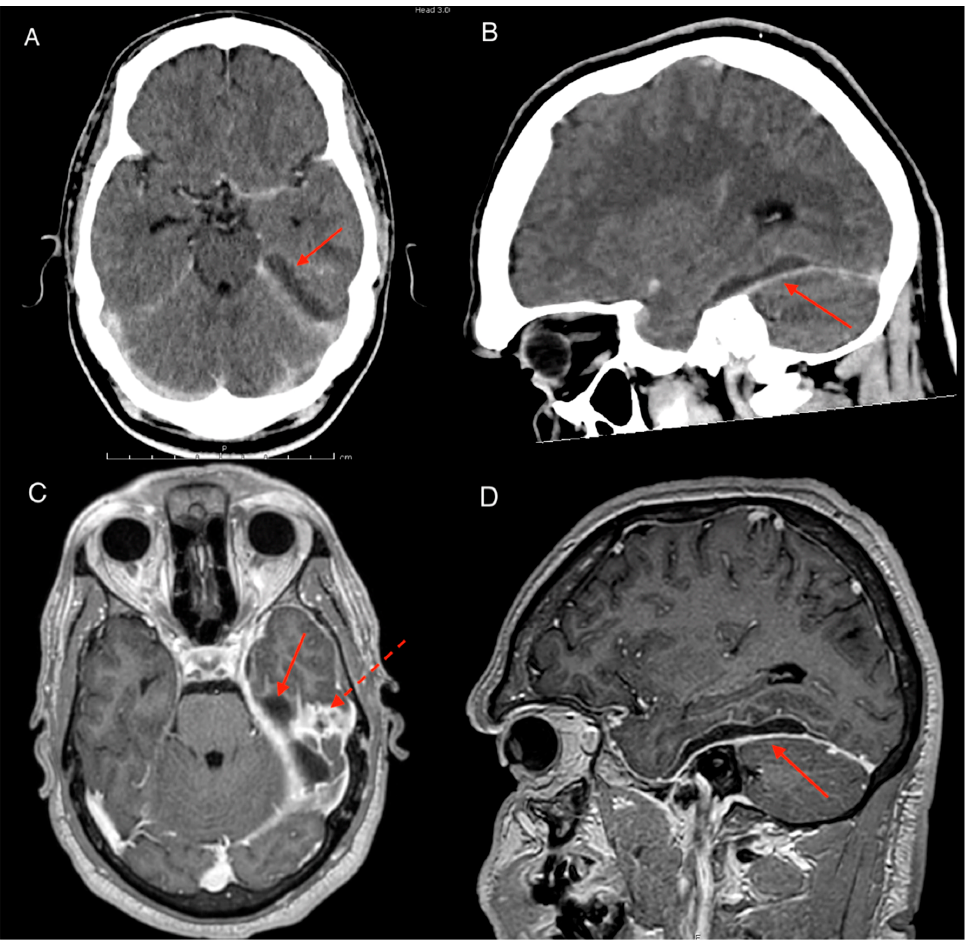
Figure 1. Imaging on presentation, contrast computerized topography (CT) and magnetic